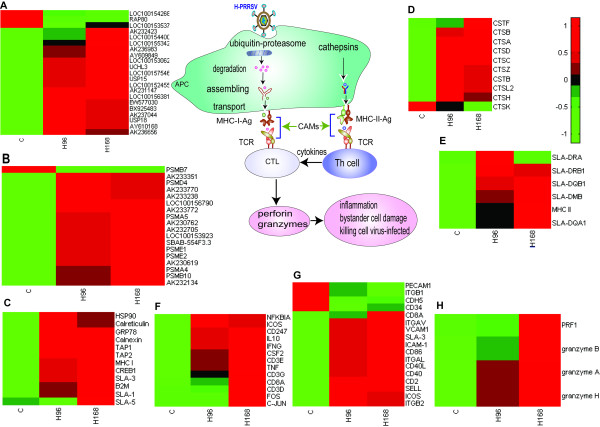
Induction of adaptive immune responses in pigs infected with H-PRRSV. (A) Ubiquitin-proteins and ubiquitin enzymes; (B) proteasome; (C) genes related to assembly and transport of MHC-I-Ag complex; (D) cathepsins; (E) genes involved in antigen presentation to MHC class IImolecules in H-PRRSV infection; (F) genes related to T cell receptor (TCR) signaling pathway; (G) cell adhesion molecules (CAMs); (H) perforin (PRF1) and granzymes. Genes shown in red were up-regulated and those shown in green were down-regulated in infected pigs relative to C pigs (See Additional file 2 for full gene names).